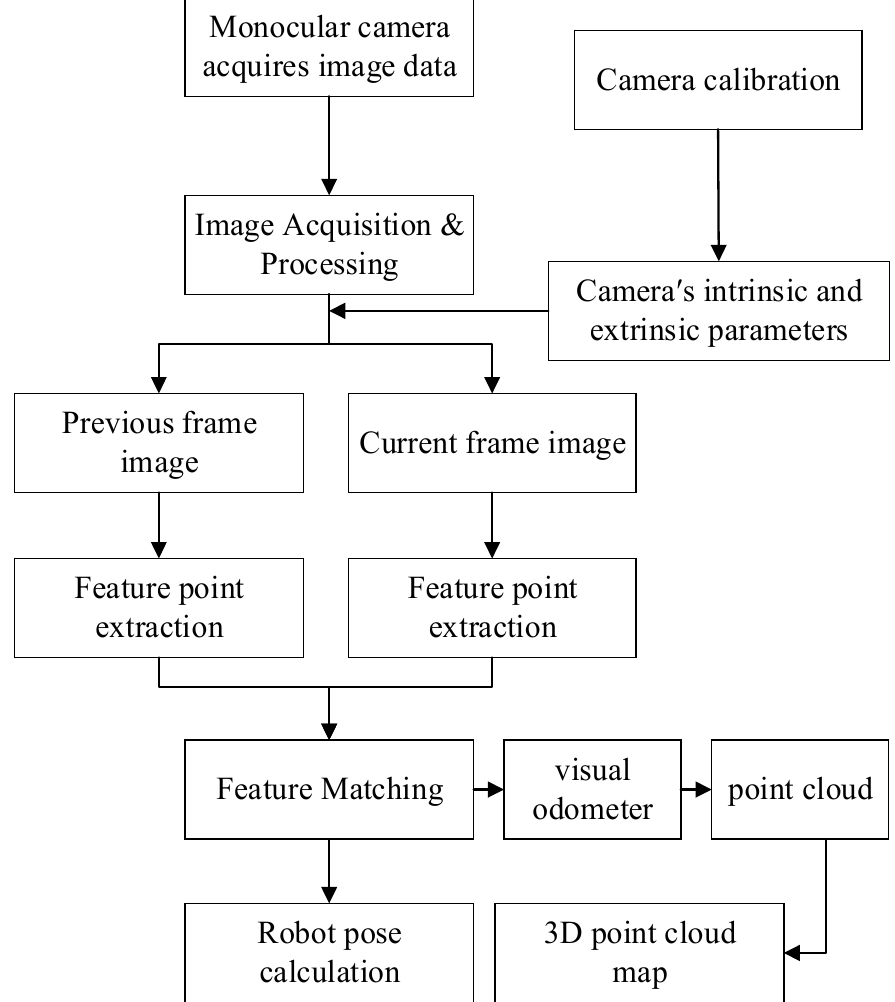
Figure 1. Positioning process of coal mine heading equipment based on uniocular vision.